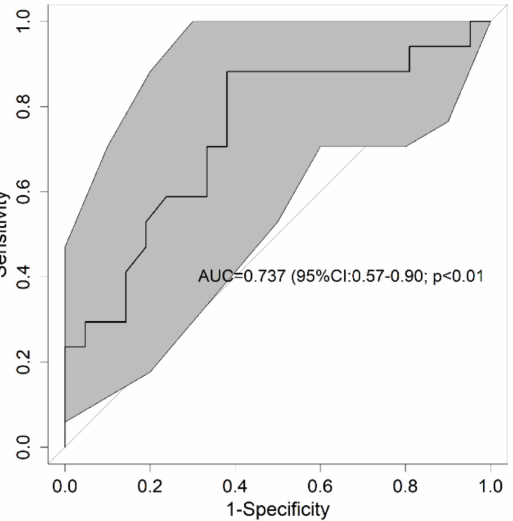
Figure 4. Receiver operational characteristics of creatinine for headaches. The bold line shows the value of the Receiver Operating Characteristic (ROC) curve and the gray shading is the result of 300 resamples. In the center of the graph is the area under the curve (AUC) and its 95% confidence interval and the p -value of the comparison against the null hypothesis (AUC = 0.5). ROC: receiver operational characteristics; AUC: area under the